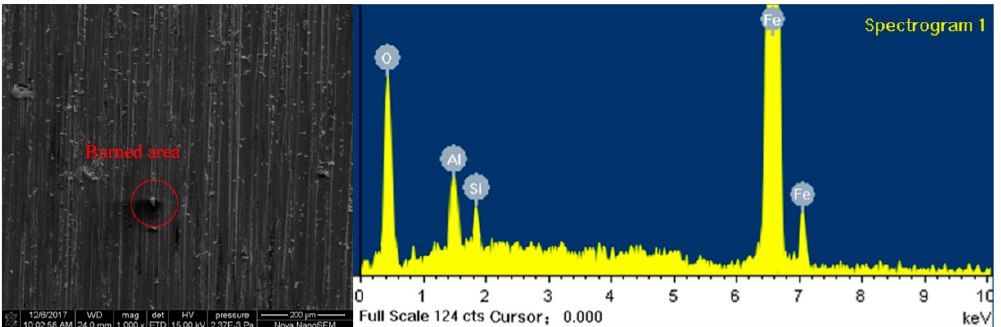
Figure 5. EDS ( Energy Dispersive Spectrocopy ) result of the burned zone. Figure 5. EDS (Energy Dispersive Spectrocopy) result of the burned